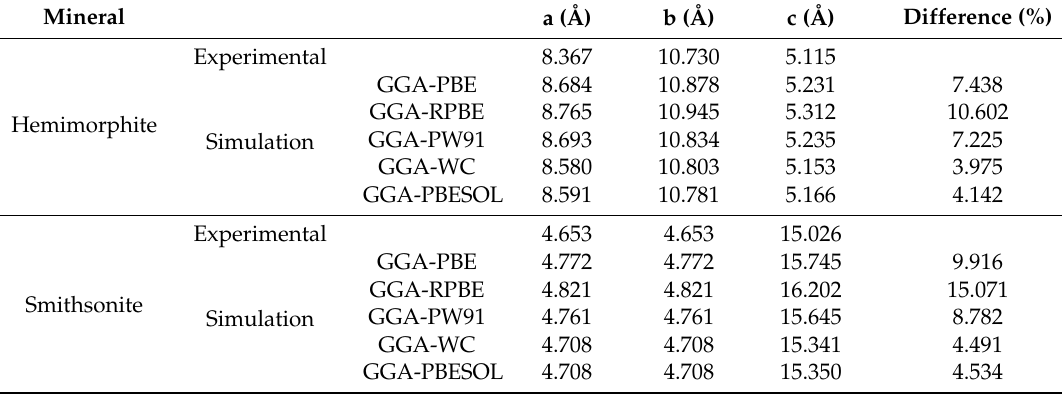
Table 1. Comparison of lattice parameters for hemimorphite and smithsonite obtained from five different density functional theory (DFT) methods with experimental values.